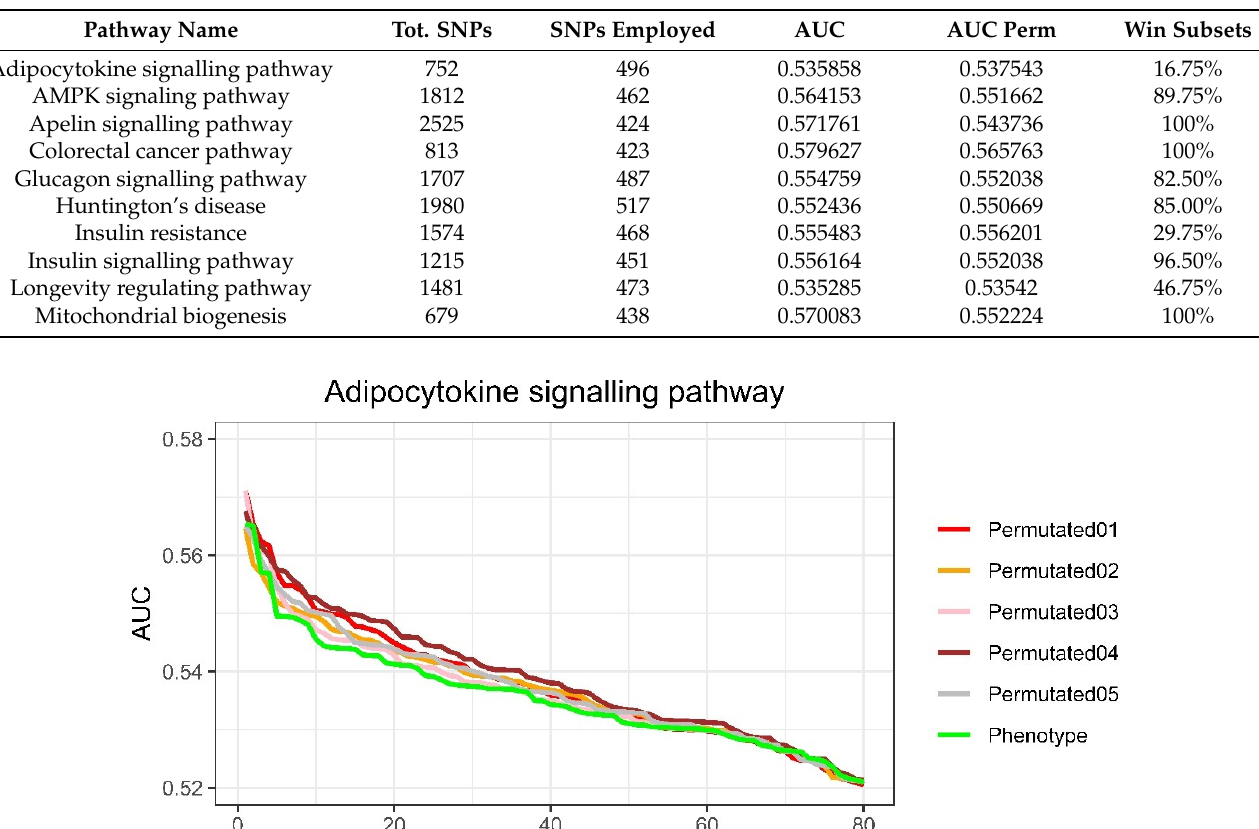
Figure 3. AUC values of the 80 iterations performed for the adipocytokine signaling pathway in the case of cases and controls (phenotype) and five different permutations.